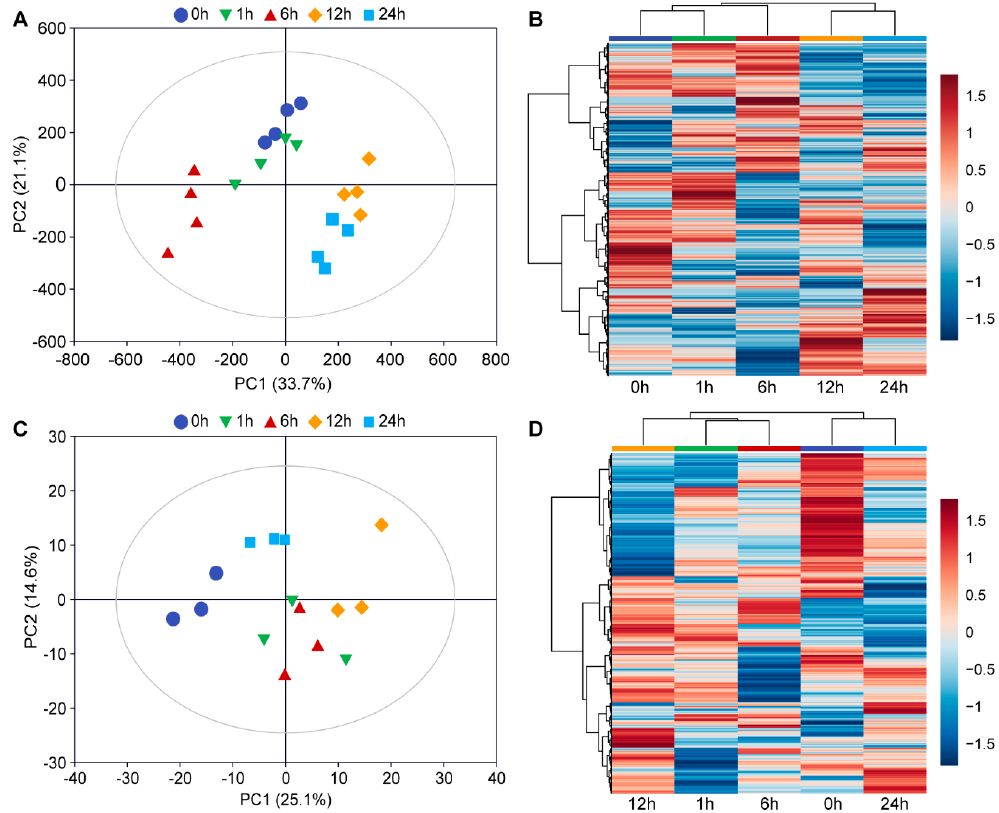
Figure 2. Overview of rice transcriptome and metabolome changes upon feeding by C. medinalis . ( A , C ) Principal component analysis (PCA) plot of all detected transcripts and metabolites in MH63 rice leaves by RNA-sequencing and metabolome profiling. Data points indicate the respective time points as feeding progressed. ( B , D ) Cluster analysis and heat maps of relative levels of expression of all transcripts and metabolites detected at di ff erent time points. Color coding represents the intensity of induction (red) or suppression (blue) of gene expression by insect